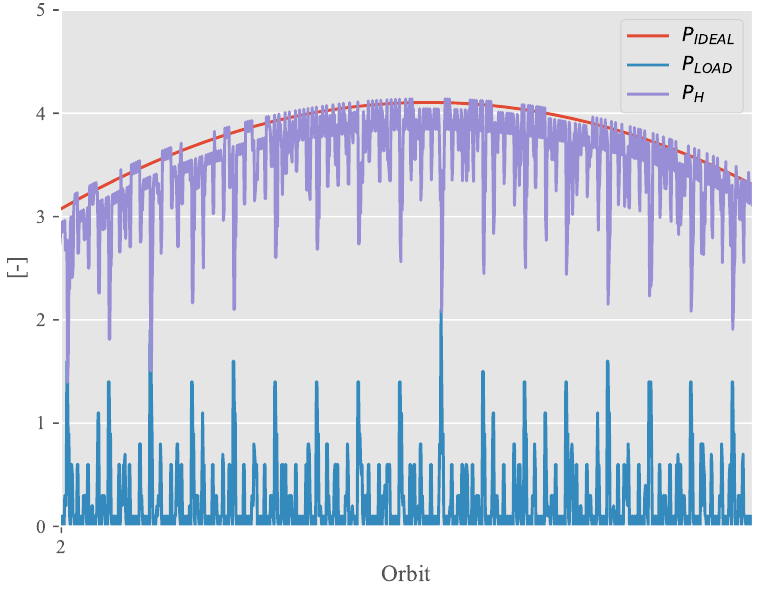
Figure 21. Total input power (under MPPT algorithm) compared with the ideal power that could be delivered in a given orbit. In this scenario, the heater is also considered as a task to be executed under the MPPT algorithm